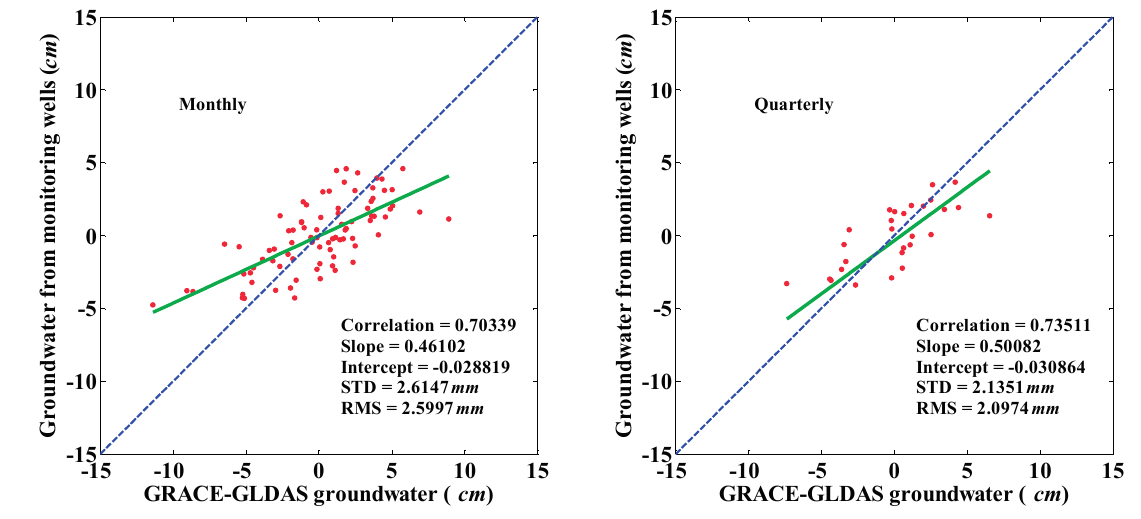
Figure 6. Spatiotemporal comparisons between monthly, quarterly groundwater variations and in-situ monitoring well observations. The significance level of the correlation coefficient is